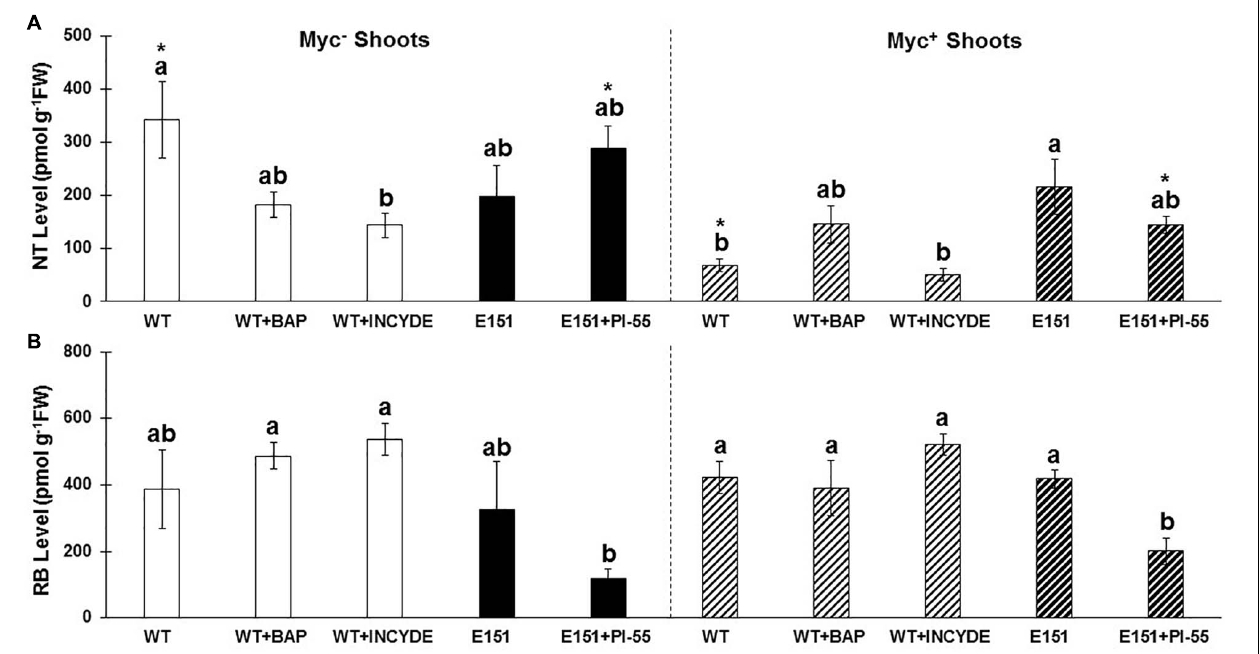
FIGURE 5 | Effects of chemical and mycorrhizal treatments on the levels (pmol g − 1 of fresh weight) of (A) nucleotides (NT; trans ZNT, cis ZNT, and iPNT) and (B) ribosides (RB; DHZR, trans ZR, cis ZR, and iPR) in the shoots of WT (white bars) and E151 (black bars) plants, the crown of which had been treated with synthetic CK status-modifying compounds. These plants were myc − (solid bars; on the left) or myc + (hatched bars; on the right). Data (mean ± SE; n = 3) were subjected to a one-way ANOVA followed by a Duncan’s post hoc test (95% confidence level). Different letters indicate significant differences between different chemical treatments of a similar mycorrhizal status. Additionally, Student’s t -tests (95% confidence level) were conducted to determine any significant differences, indicated by asterisks, between similar treatments of differing mycorrhizal status within a pea